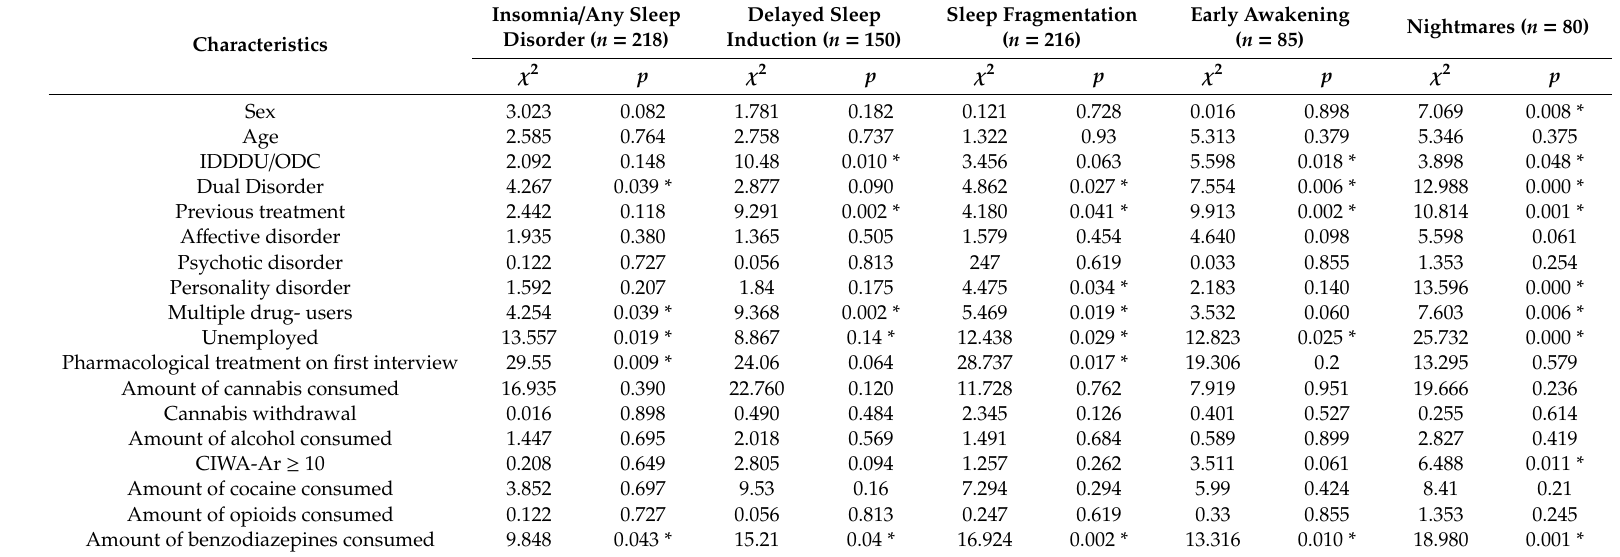
Table 3. Relationships between variables analyzed with non-parametric test chi-square and p -values. Abbreviations; IDDDU: Inpatient Dual Diagnoses Detoxification Unit; ODC: Outpatient Drug Clinic. *: significant values with p <